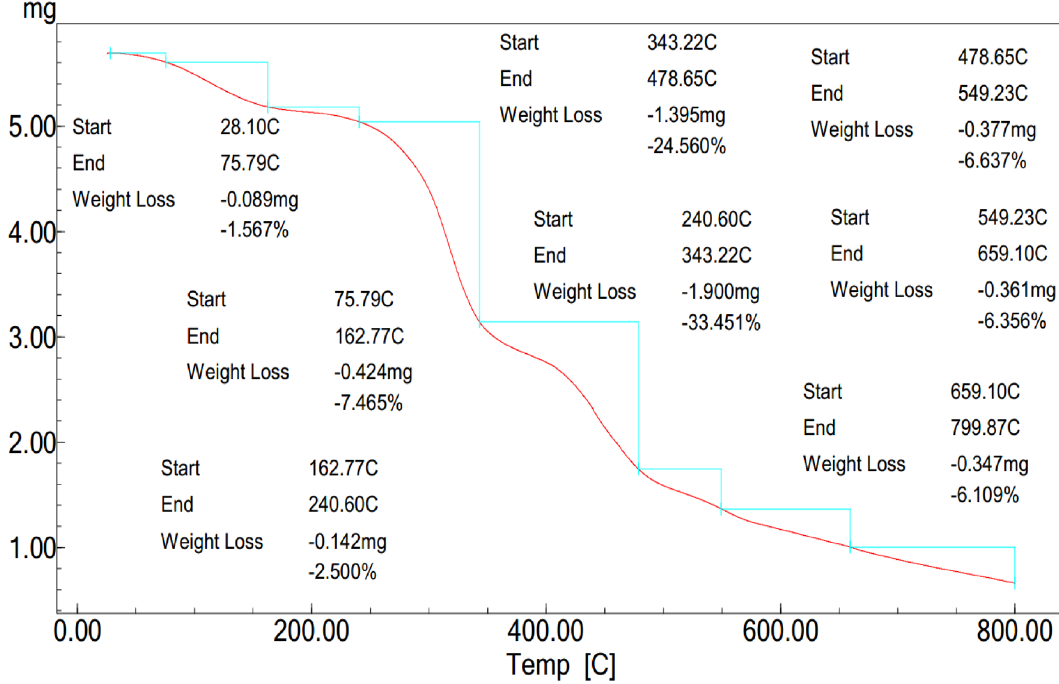
Figure 7. TGA curve of the fabricated (Z3C1) nanocomposite.